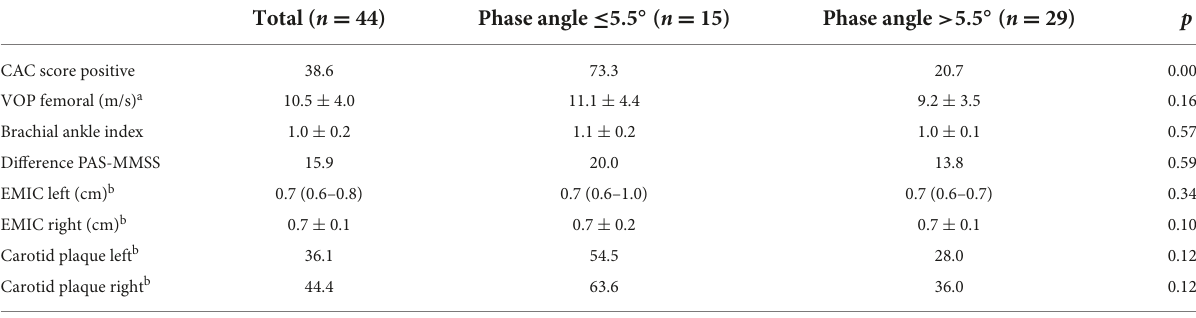
TABLE 4 Atherosclerosis markers of peritoneal dialysis (PD)